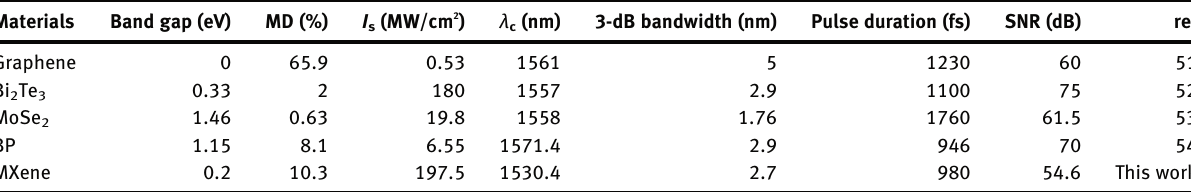
Table  : The comparison of the output laser characteristics in resonators based on different SA devices [  –  ]. Materials Band gap (eV) MD (%) I s (MW/cm  ) Graphene Bi  Te  MoSe